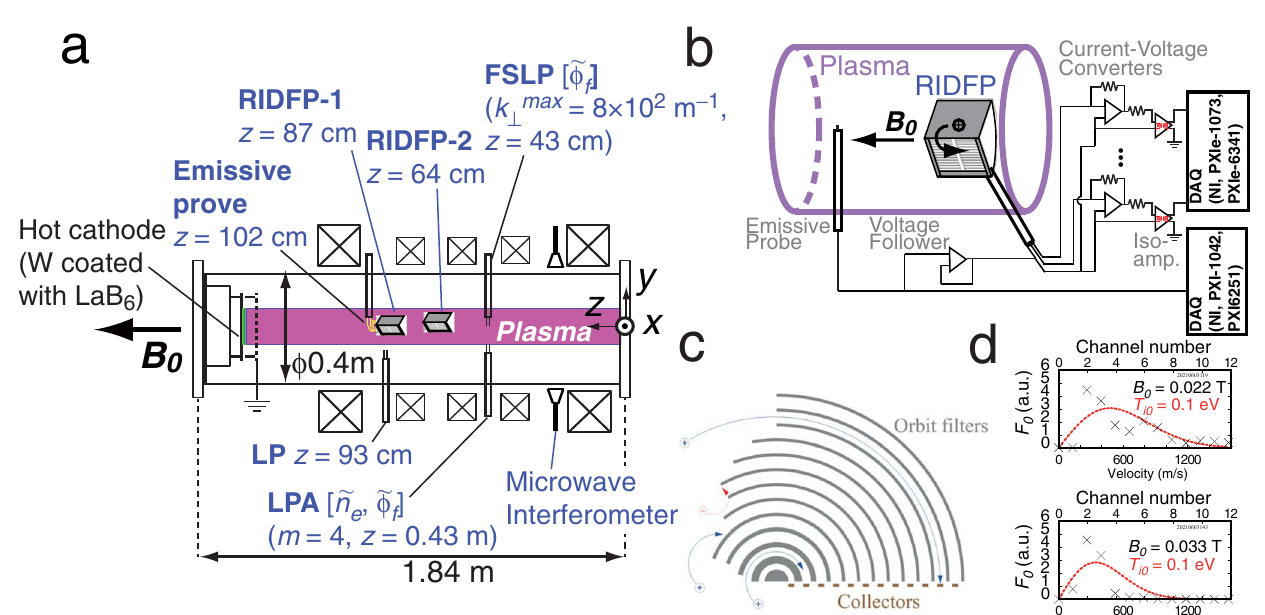
Fig. 3 Experimental setup. a Schematic diagram of the MPX plasma device including diagnostic systems. b System diagram of RIDFP (Ring-averaged ion velocity distribution function probe). c Schematic of the orbit fi lters and collector of the incoming gyrating ions. d Examples of equilibrium ring-averaged ion velocity distribution functions F 0 at a fi xed guiding center position for the background magnetic fi eld strength B 0 = 0.022T and B 0 = 0.033 T, respectively. The red solid curves indicate Maxwellian having the temperature of 0.1 eV. Shrink of orbits of the ions (Larmor radii) for the B 0 change from 0.022 T to 0.033 T can be clearly observed, indicating validity of RIDFP